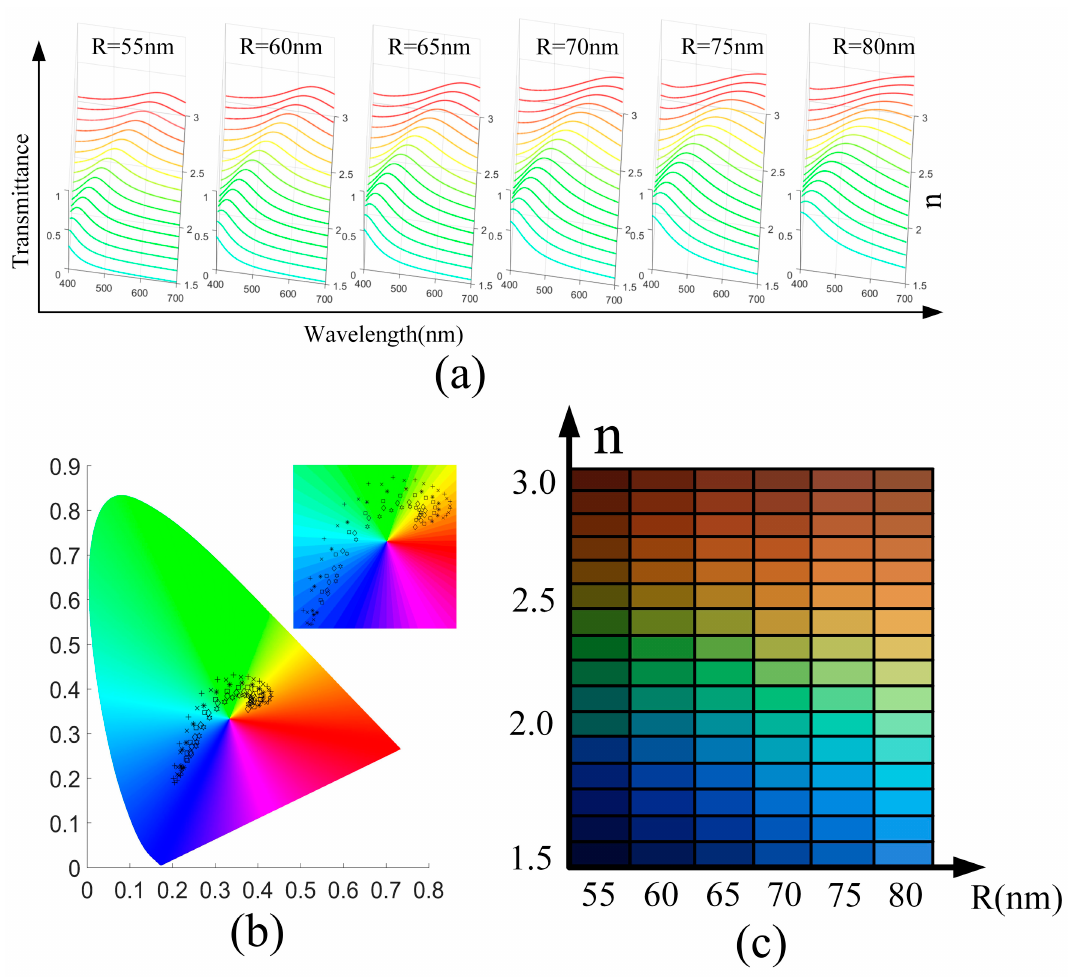
Figure 5. ( a ) Transmittances under the different refractive indices 1.5–3.0 and the hole radius 55 nm–80 nm. ( b ) CIE1931 color space inversion map distribution under different conditions. Among them, the illustration is a partially enlarged drawing. ( c ) Color display under the different refractive indices and hole radius.